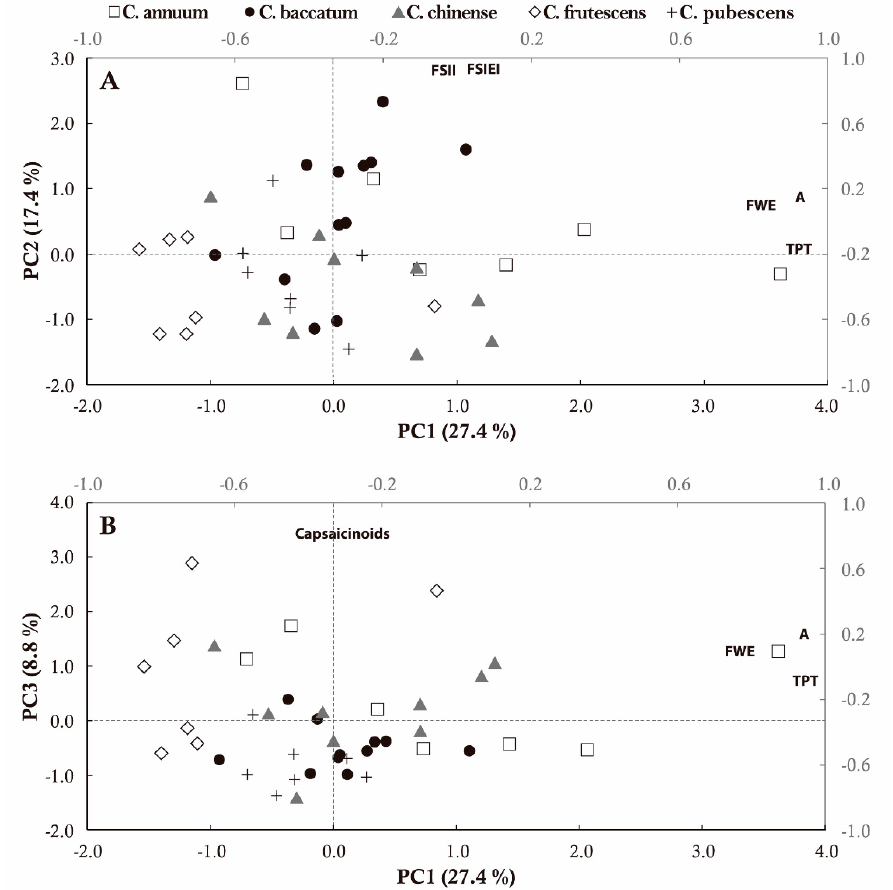
Figure 4. Scatter plot of the principal component analysis (PCA) analysis for forty-two Ecuadorian pepper landraces. ( A ) Principal Component 1 (PC1) vs. PC2; ( B ) PC1 vs. PC3. Secondary axes show the factor loadings values. Traits with the highest factors for each component are represented.